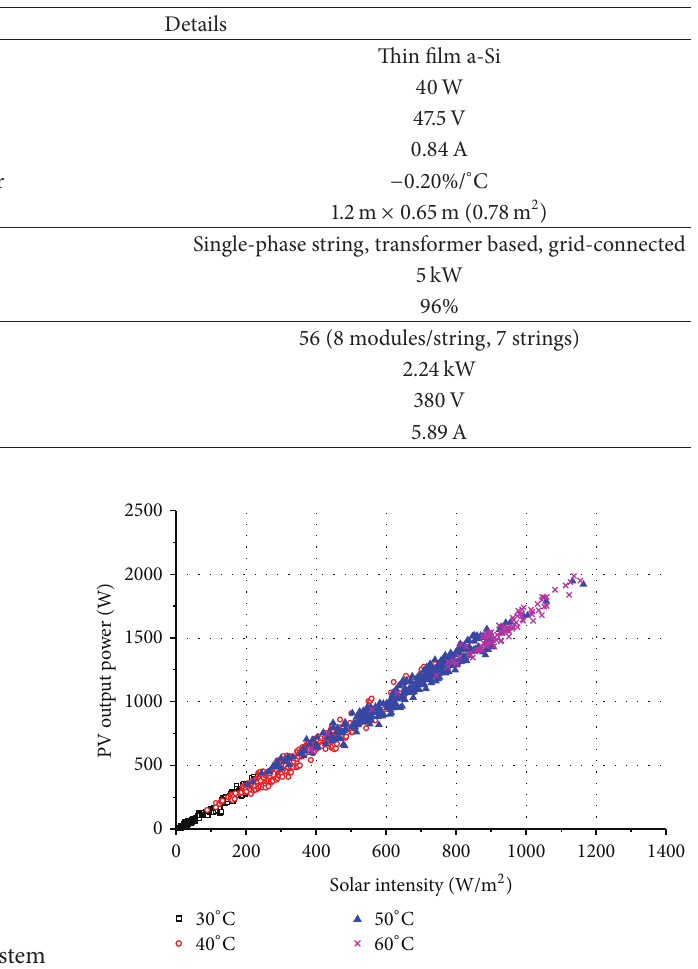
Figure 2: Relation of solar irradiance to PV output power and variation in module temperature.